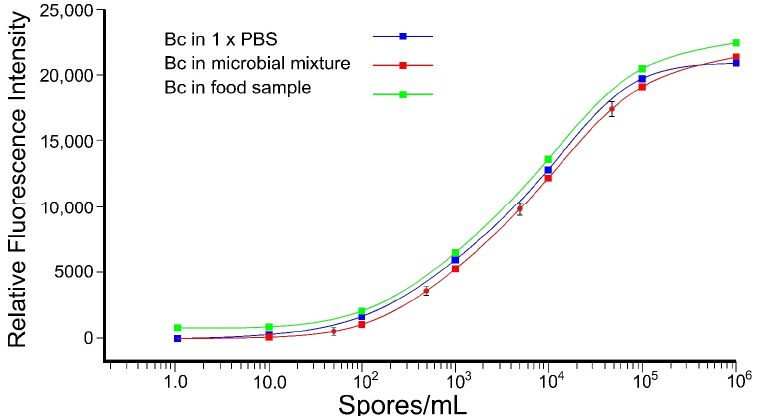
Figure 6. Range of detection using xMAP system. Detection of B. cereus (Bc) spore lysate with llama rAb4 in 1 × PBS (blue curve), in food sample/5% baby cereal (green curve) and the presence of 6 different microorganisms as a microbial mixture in 1 × PBS (red curve). This experiment was performed in triplicate, and no significant difference was observed. The error bars represent standard deviations for tested samples (red dots) at 50, 5 × 10 2 , 5 × 10 3 , and 5 × 10 4